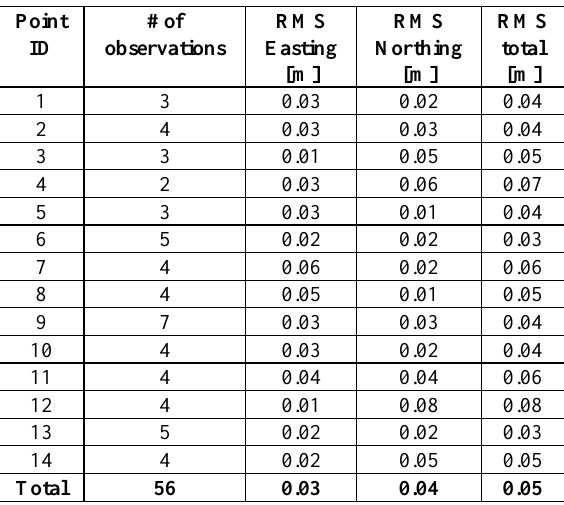
Table 1: Ortho-image accuracy